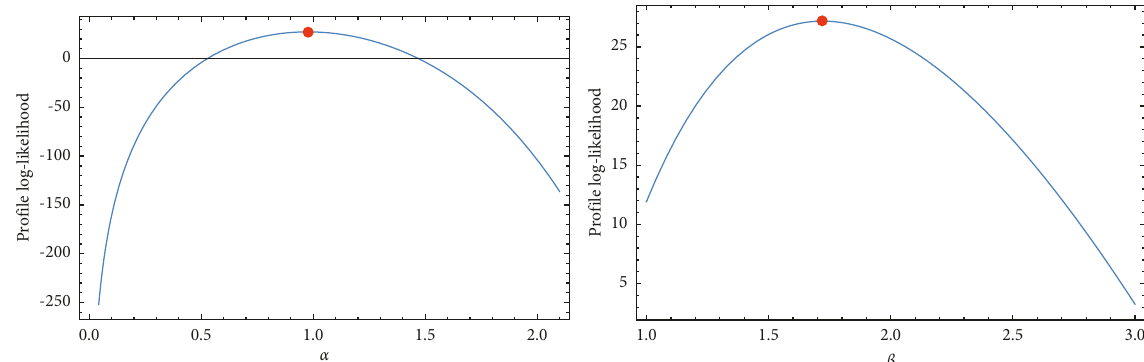
Figure 12: The profile of the log-likelihood functions for α and β of the milk data set.